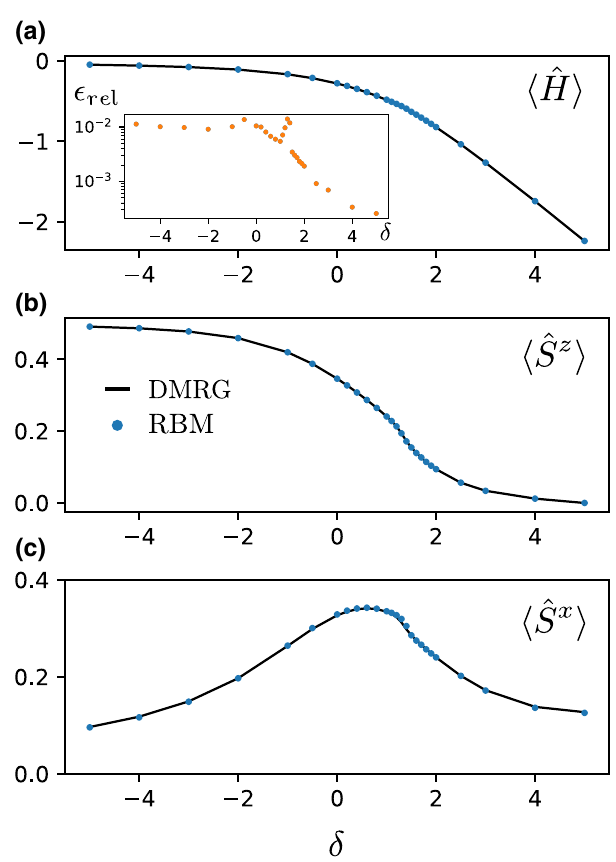
FIG. 4. Quantum state tomography of an 8 × 8 array of Ryd- berg atoms with unsupervised learning of single-shot atomic occupation data. We compare various observables measured using the MPSs obtained from DMRG (black line) and the neural-network wave functions learned from data generated at different values of the detuning δ . We plot the average energy per spin (a) and the average magnetization along the z axis (b) and x axis (c). The inset in (a) shows the relative error in the energy (cid:14) rel = | E RBM − E DMRG | / | E DMRG . Error bars estimated via standard deviations are too small to be